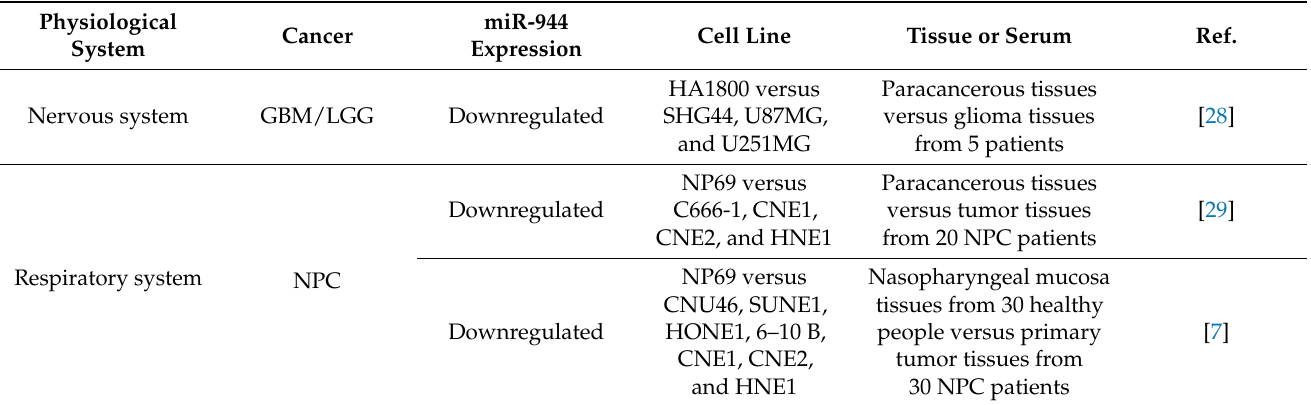
Table 1. Aberrant expression of miR-944 in different